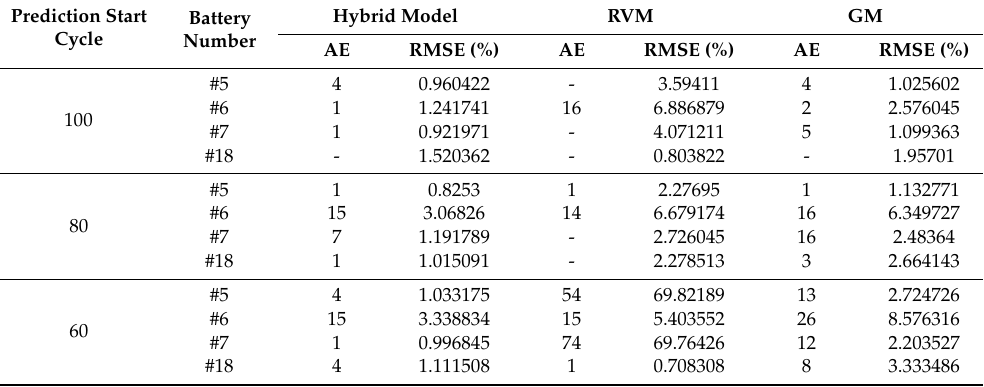
Table 1. Comparison of prediction results of the hybrid method with the relevance vector machine (RVM) and the gray model